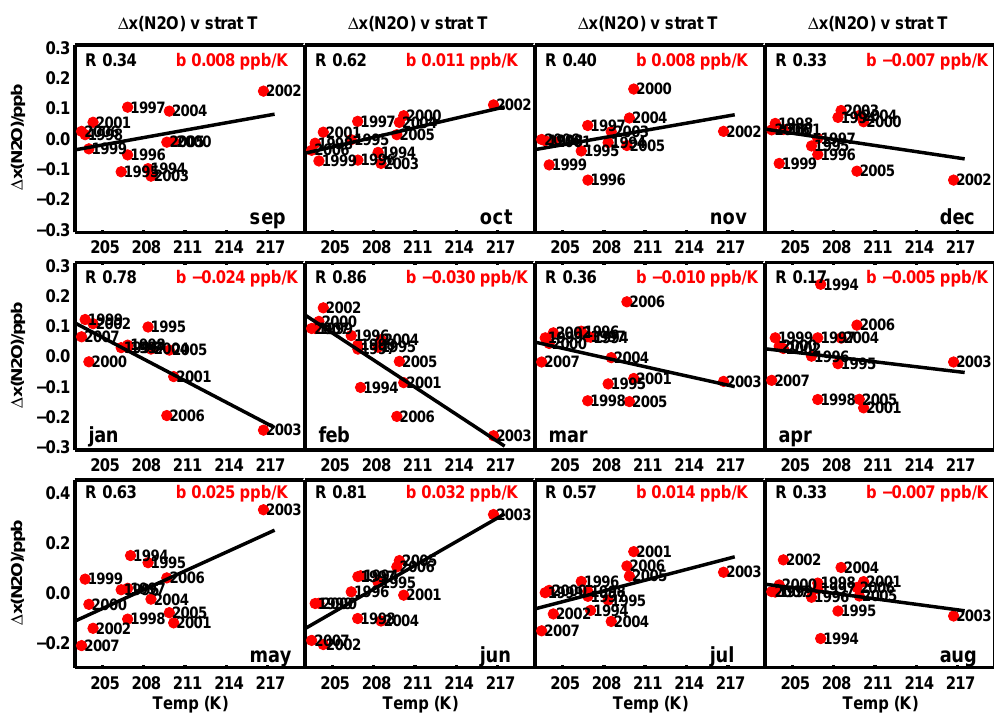
Fig. 9. Detrended AGAGE N 2 O data at Cape Grim, Tasmania (from Fig. 1b), sorted by month and plotted vs. mean polar (60–90 ◦ S) spring (September–November) lower stratospheric (100hPa) temperature from NCEP reanalysis data. The mean of the detrended N 2 O data for each month is subtracted to permit all months to be plotted on a similar y-axis scale. The Pearson’s correlation coefficient R and the slope b of each linear regression are shown. Note that the year labels correspond to the year of the detrended N 2 O monthly means, which for January–August are plotted against the previous year’s spring (September–November) stratospheric temperature, when cold air is still generally trapped in the polar vortex. A sudden stratospheric warming occurred in September 2002, leading to anomalously warm polar temperatures in the spring lower stratosphere (Glatthor et al.,